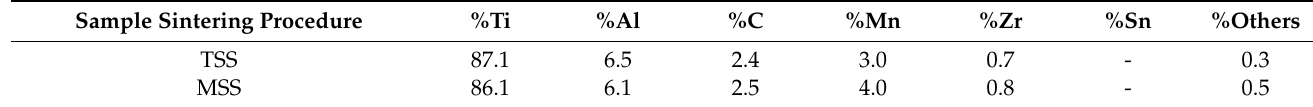
Table 2. Weight percentage of different elements identified in the investigated samples.